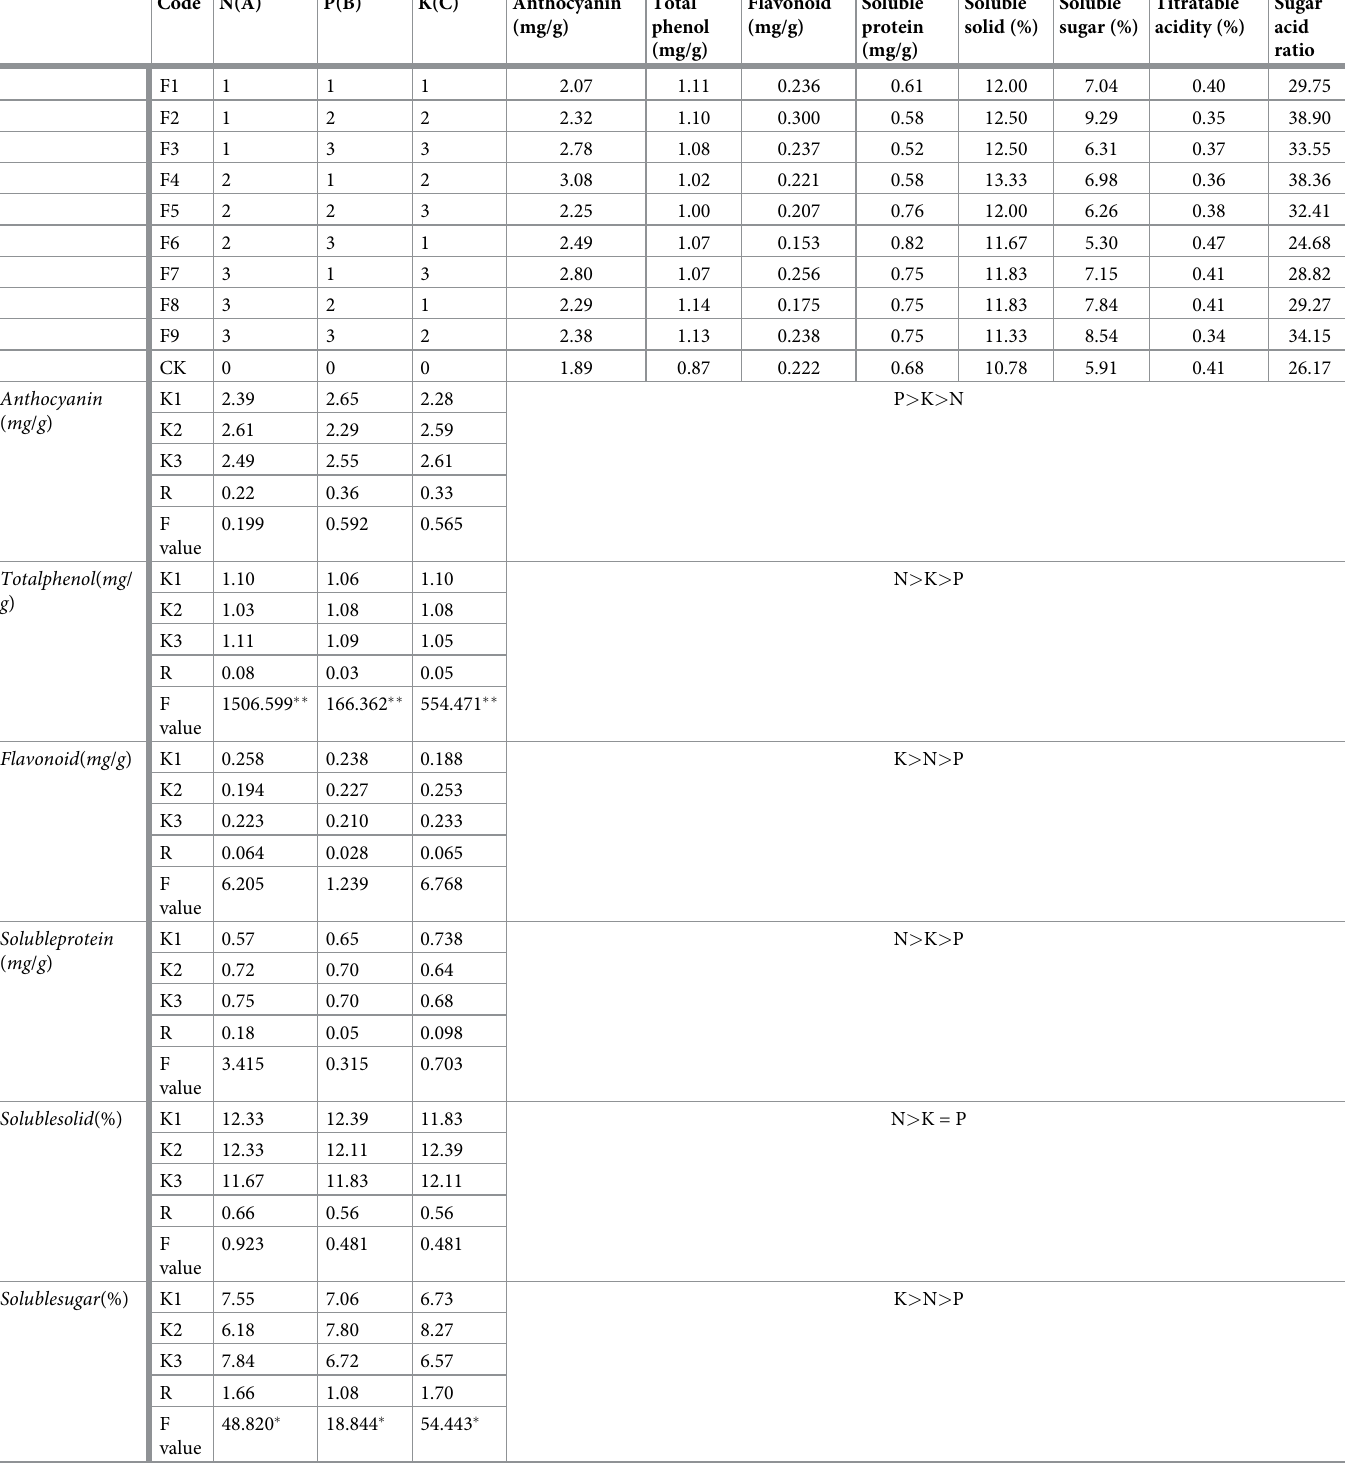
Table 4. Orthogonal test on results and analysis of orthogonal test on blueberry fruit